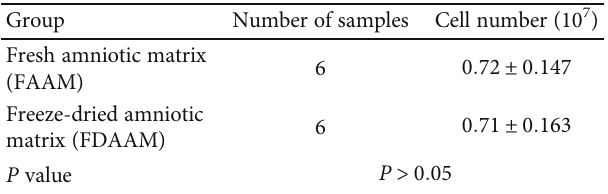
Table 1: Cell number loaded on the amniotic matrix before and (cid:1) X ± S after lyophilization (